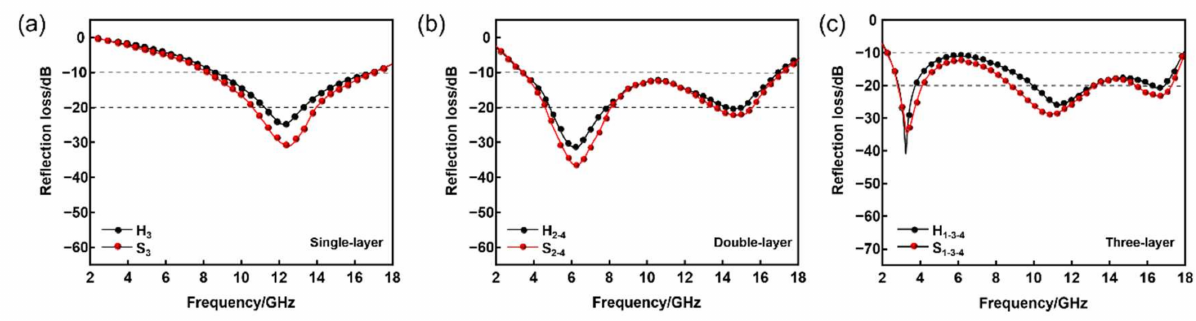
Figure 10. Comparison of RL between HC composites and SHC absorber. ( a ) Single-layer, ( b ) double- layer, ( c )